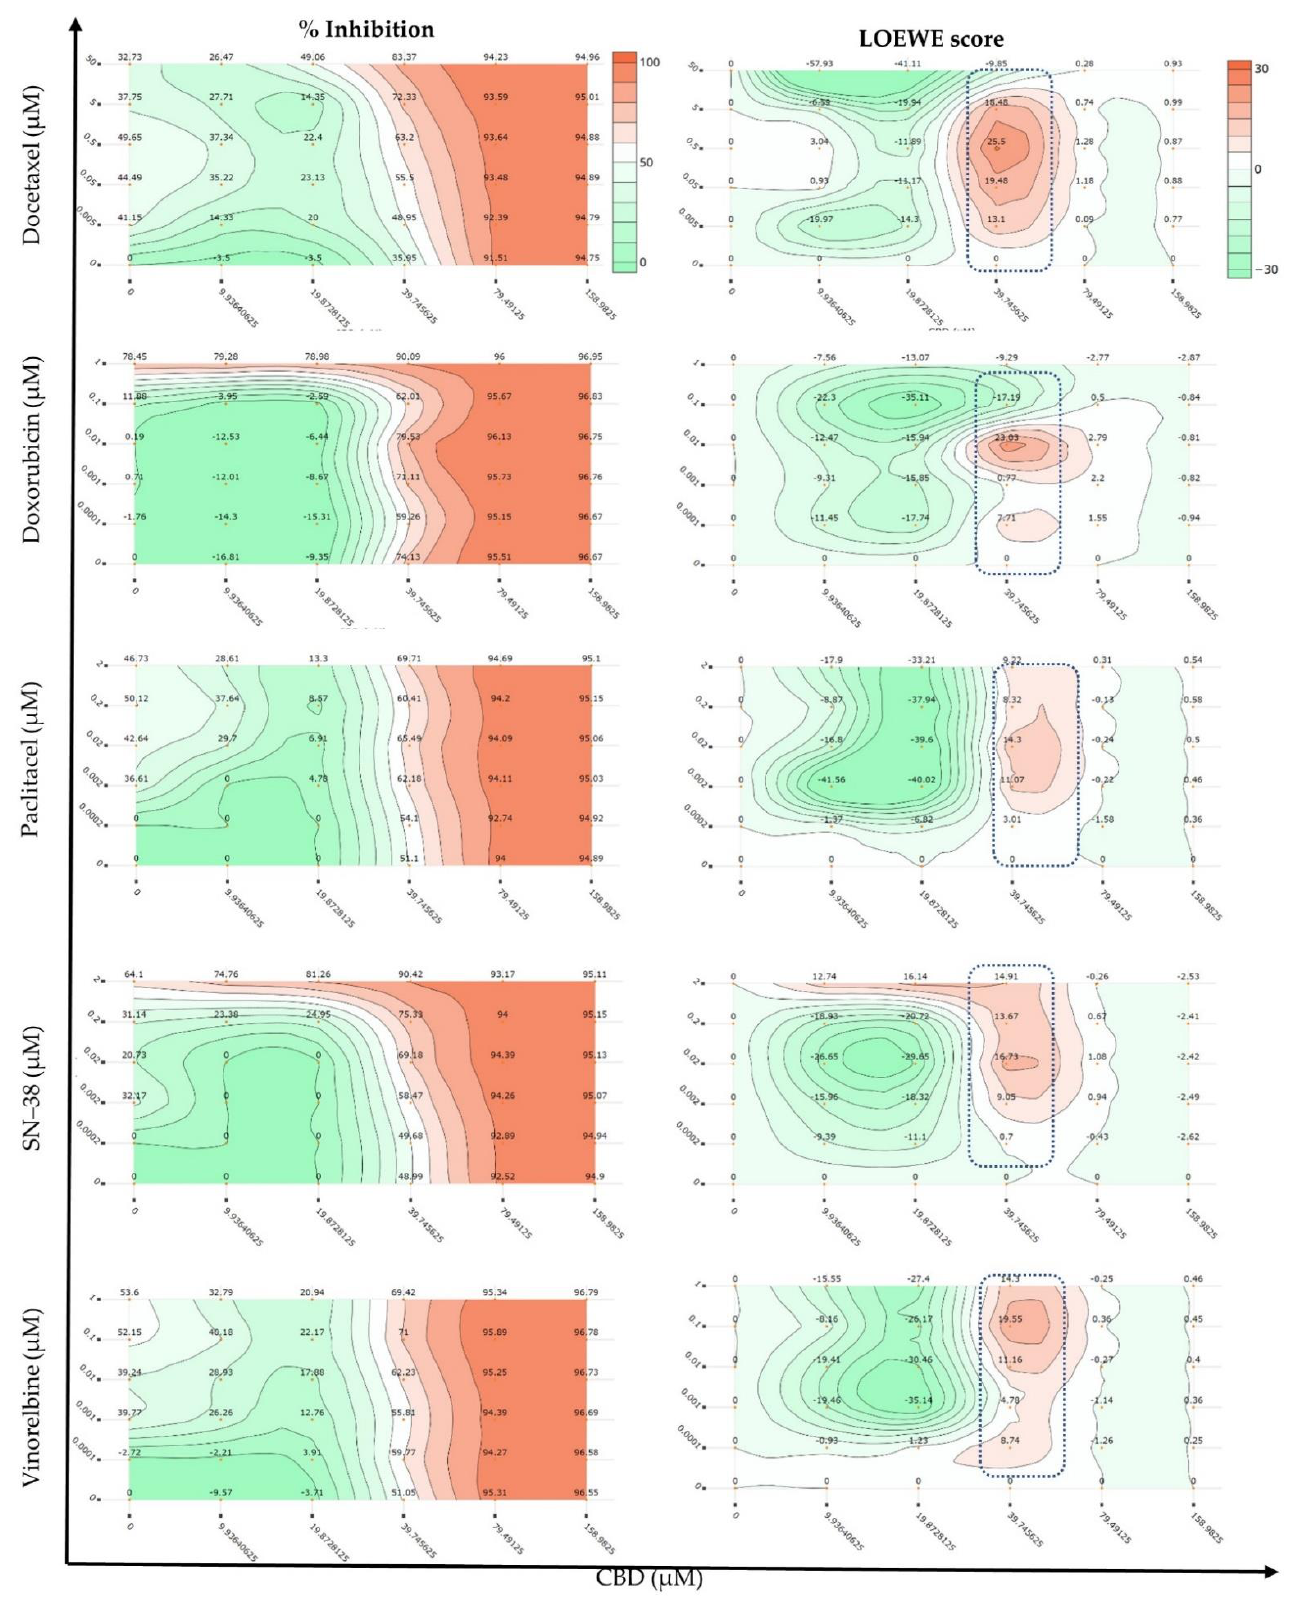
Figure 1. Dose–response and Loewe synergy quantitation of cannabidiol (CBD) combinations with the chemotherapeutic drugs against MCF7 cells in a checkerboard assay ( n = 3).